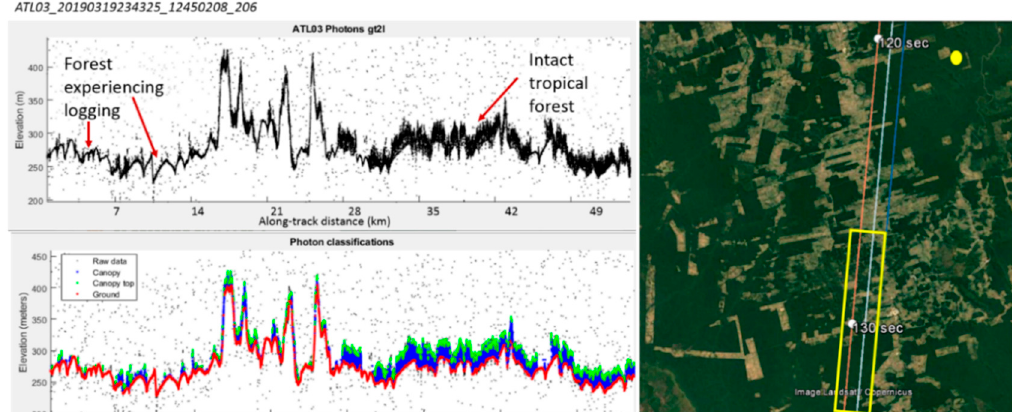
Figure 5. Deforestation in Brazil. The top panel of approximately 50 km of ATL03 photons from the strong beam of track 2 (GT2L) over tropical forest in Brazil acquired 19 March 2019. The bottom panel is the result of the ATL08 algorithm surface classification labels for ground photons (red), intermediate canopy photons (blue), and top of canopy photons (green). The panel to the right depicts the location of the ICESat-2 track in Google Earth for context [14,22].